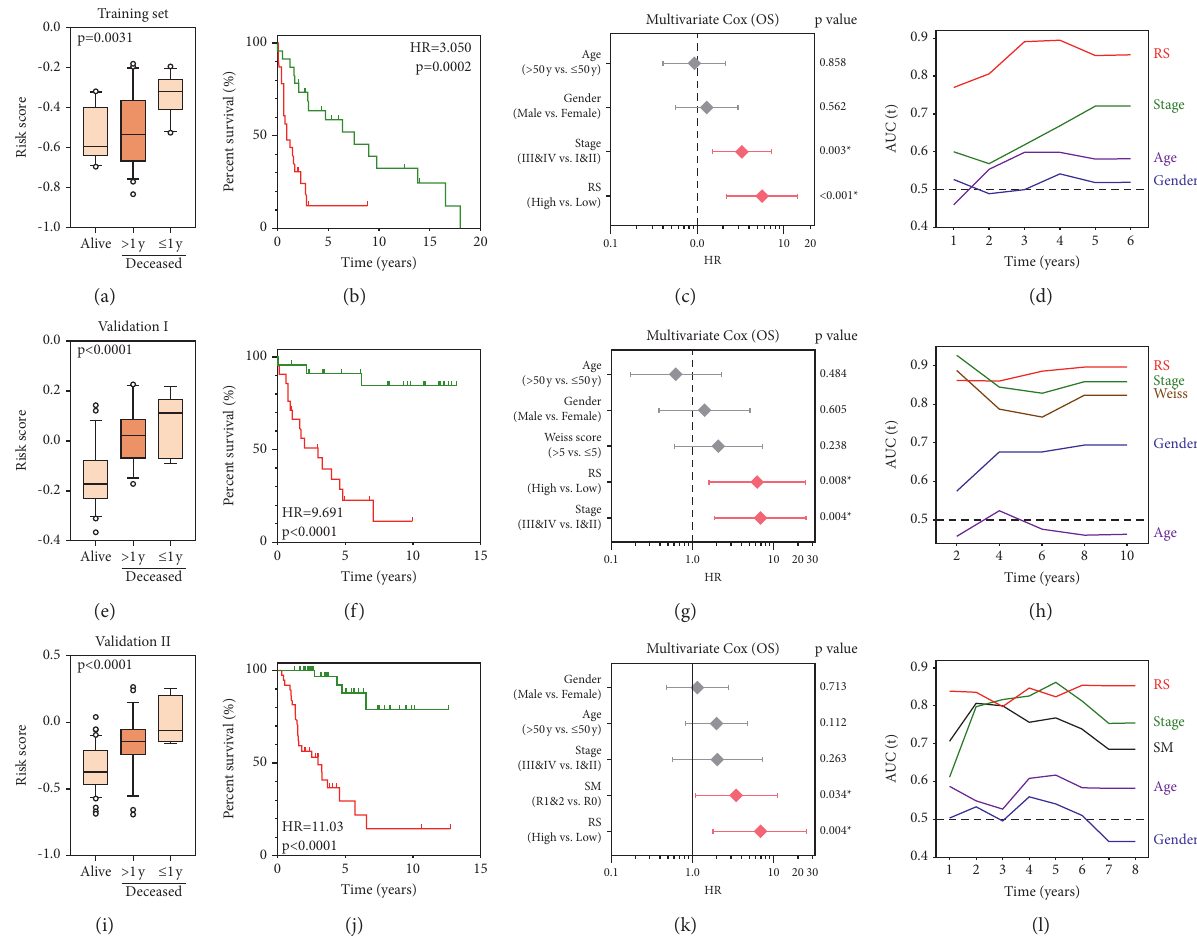
Figure 2: Gene signature-derived risk score serves as a risk factor and reliable predictor for overall survival in each cohort. (a–d) In the training cohort, the signature-based risk score was significantly elevated in patients who died during follow-up, especially in the short-term survival group. Kaplan–Meier survival analysis demonstrated a worse prognosis in patients with a high-risk score. Multivariate Cox regression analysis showed that risk score and TNM stage were independent risk factors for overall survival. At different time points, tROC analysis showed risk score was an accurate predictor for survival with even better performance than TNM stage. (e–h) Validation cohort I. (i–l) Validation cohort